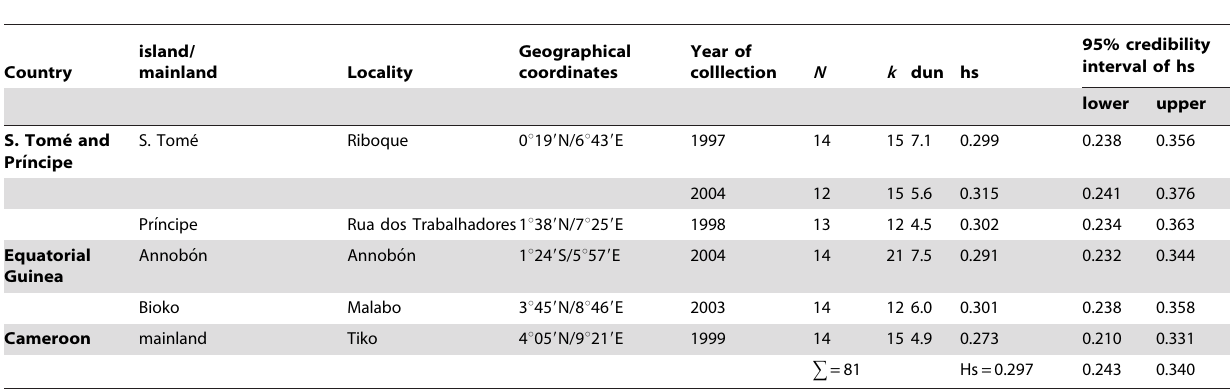
Table 1. Collection data, site occupancy and genetic diversity of the sampled Anopheles gambiae populations.